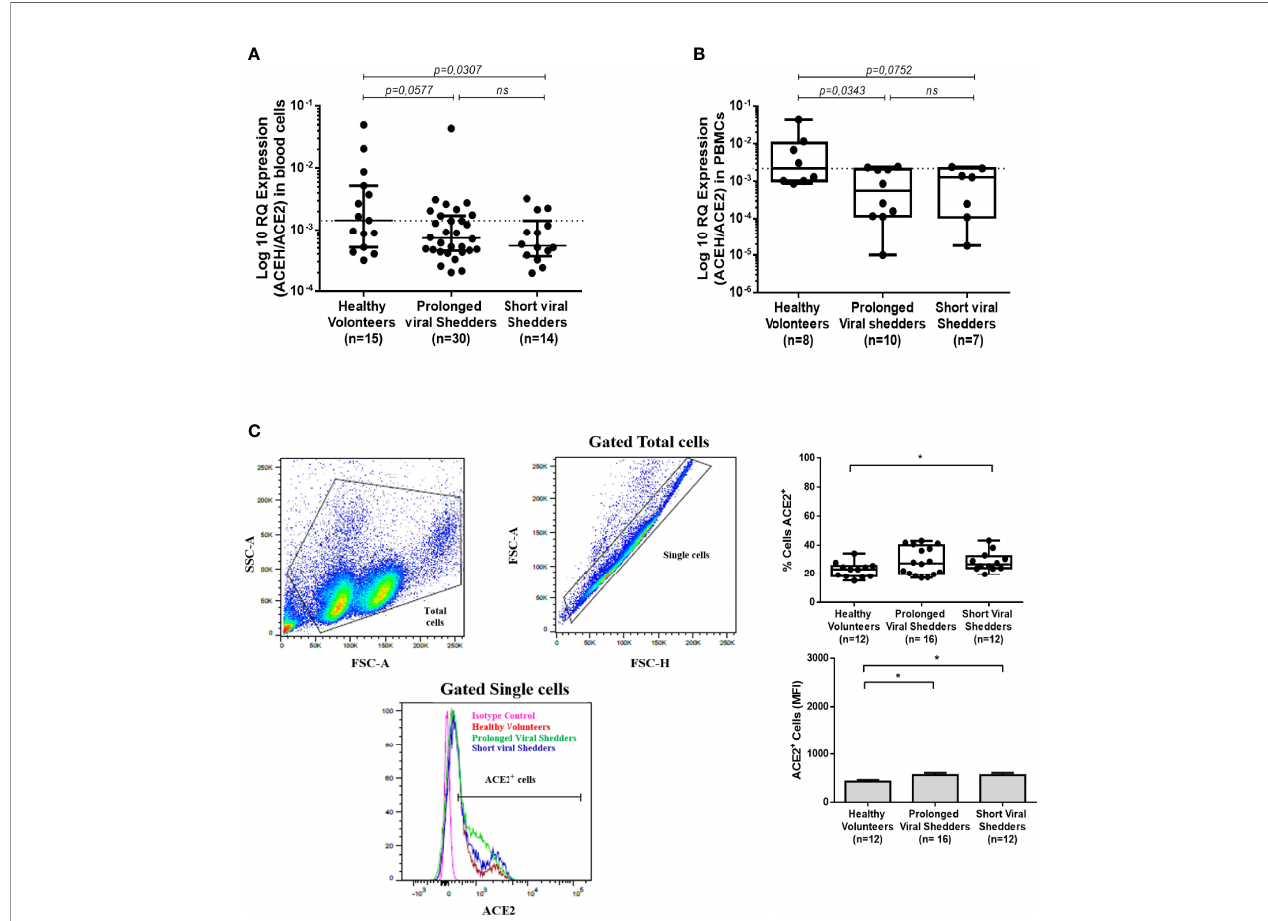
FIGURE 1 | ACE2 mRNA expression in blood cells and PBMCs, and monocytes from COVID-19 patients and healthy volunteers. (A) Expression of ACE2 mRNA in circulating blood cells (both mononuclear and polynuclear cells) from the prolonged viral shedders (n = 30) and the short viral shedders (n = 14) groups, compared to a healthy volunteers control group (n= 15). The results (presented as median with con fi dence interval) are expressed as log10 RQ were RQ = 2 ( − D CT) . (B) Expression of ACE2 mRNA in peripheral blood mononuclear cells (PBMCs) samples from the three different groups studied: prolonged viral shedders (n = 10), short viral shedders (n = 7), and healthy volunteers (n= 8). The data are expressed as log10 RQ were RQ = 2 ( − D CT) . (C) Flow cytometry analysis of ACE2 expression at the surface of total blood cells from prolonged viral shedders (n=16) and short viral shedders (n=12) versus total blood cells from healthy volunteers (n=12). The left panels show the gating parameter chosen (from individual to individual, between 8 and 40% of the total blood cells express ACE2 at their surface); the upper right panel indicates the percent of cells expressing ACE2 while the lower right panel is an histogram representing the mean fl uorescence intensity (MFI) The Mann – Whitney test was used for the statistical analysis of all the data. The result was considered signi fi cant when the p value < 0.05: *; ns for not signi fi cant